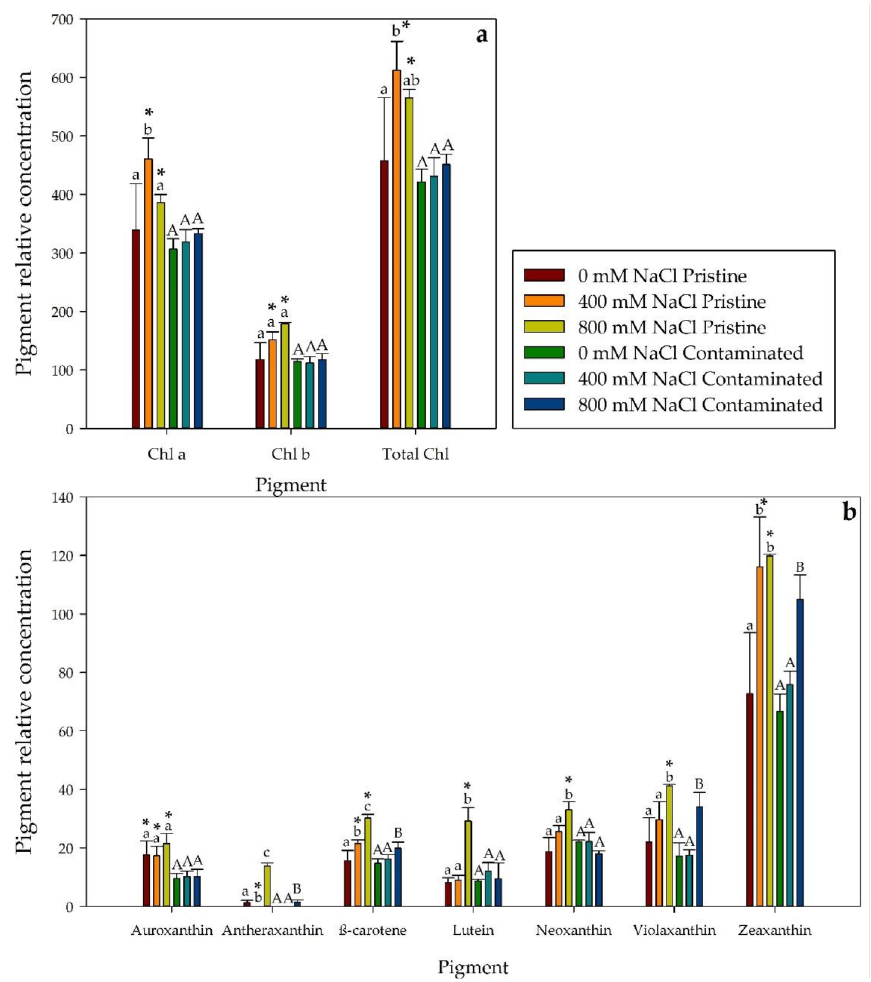
Figure 4. Pigment relative concentration. ( a ) Leaf chlorophyll a (Chl a ), chlorophyll b (Chl b ), total chlorophyll (Total Chl), ( b ) auroxanthin, antheraxanthin, β -carotene, lutein, neoxanthin, violaxanthin and zeaxanthin concentration ( µ g g − 1 FW) in S. patens individuals from pristine and heavy metal contaminated sites (average ± standard error, N = 5), along with the tested NaCl concentrations. Letters indicate significant differences between treatments at p < 0.05; asterisks mark significant differences between populations at p <